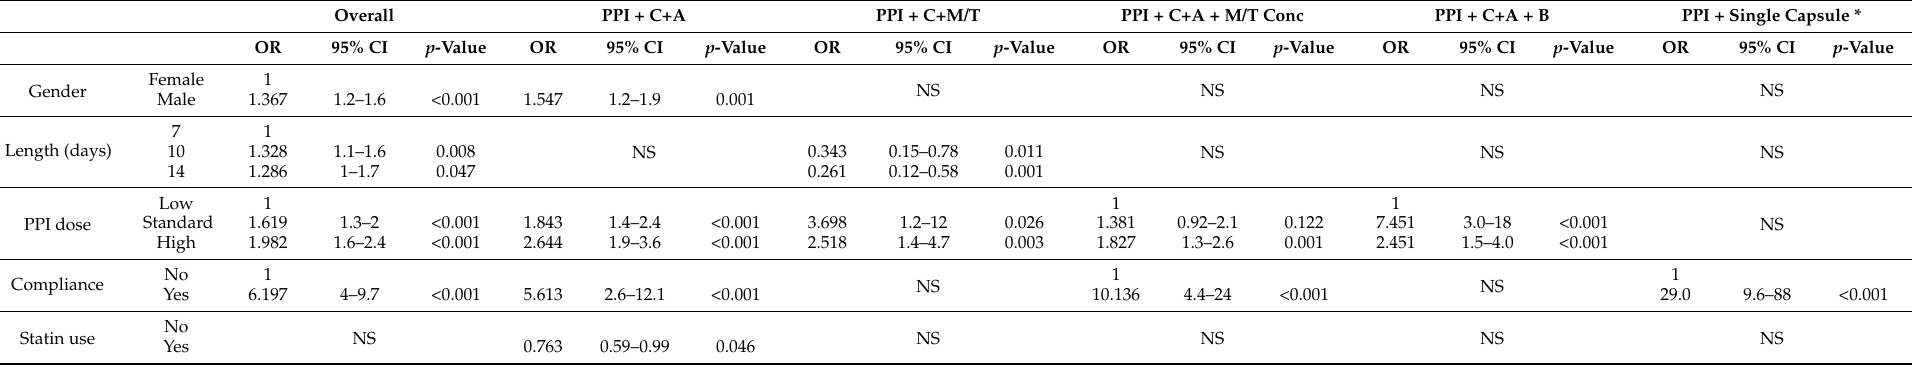
Table 6. Multivariate analysis of mITT effectiveness in first-line empirically prescribed